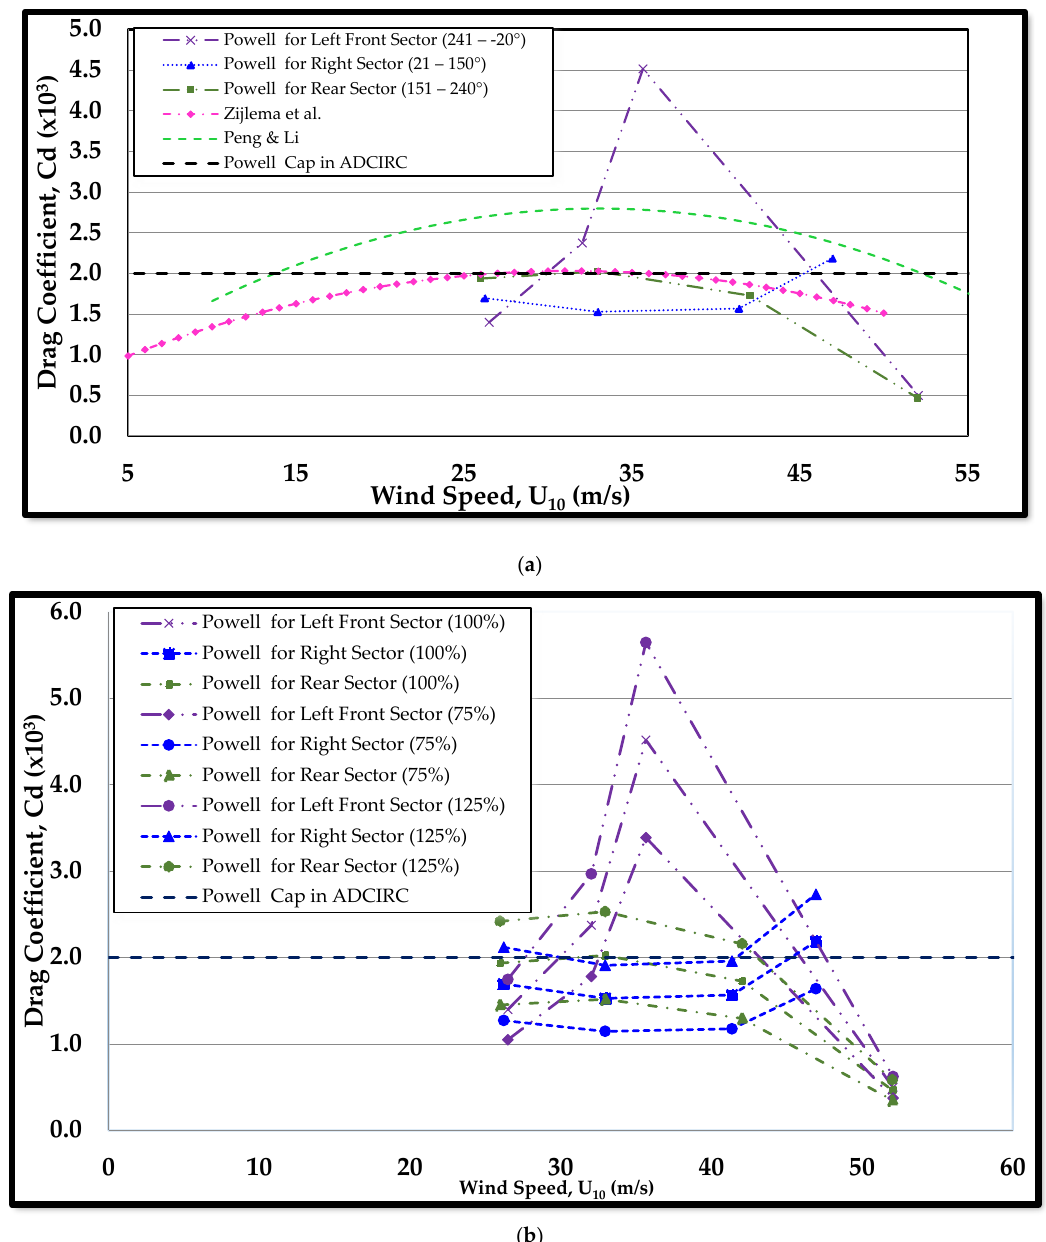
Figure 1. Unstructured ULtralite-Levee-Removed (ULLR) [1] mesh ( a ) resolution; ( b ) observation station locations with respect to Hurricane Rita track. Note that the bathymetry is manually set between 1 m and −1 m to show the shoreline. Here a negative bathymetry represents above sea level. In this study, a wind drag coefficient due to Powell [44] with a cap of Cd ≤ 0.002 [1] is used in ADCIRC, and this is the default setup. Typically, SWAN applies a wind drag coefficient due to Wu [46] with a cap of Cd ≤ 0.0035 [6]; but for this study, SWAN uses whatever wind drag coefficient used in ADCIRC [1]. Drag coefficient formulations of Zijlema [15] and Peng & Li [43] are used to investigate how these affect hurricane storm surges. Figure 2a shows how Powell, Zijlema and Peng & Li drag coefficient profiles vary with respect to wind speed. The drag coefficient profile of Zijlema typically resides in the lower envelope of most profiles available in the literature [16], while that of Peng & Li resides at the upper envelope of the lot. Figure 2b displays the 75% and 125% of Powell’s sector based drag coefficient profiles. The main tidal constituents, K1, O1, Q1, P1, M2, K2, N2, and S2 are generated from the EC2001 tidal database [47,48].